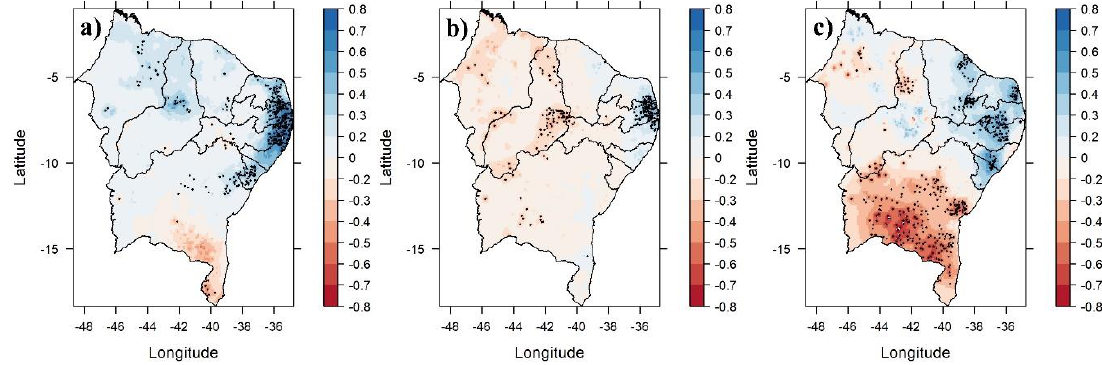
Figure 2. Trend of SPEI-3 / decade for the NDJ quarter in quantiles ( a ) Q5, ( b ) Q50 and ( c ) Q95. The black points indicate municipalities whose series presented statistical significance.